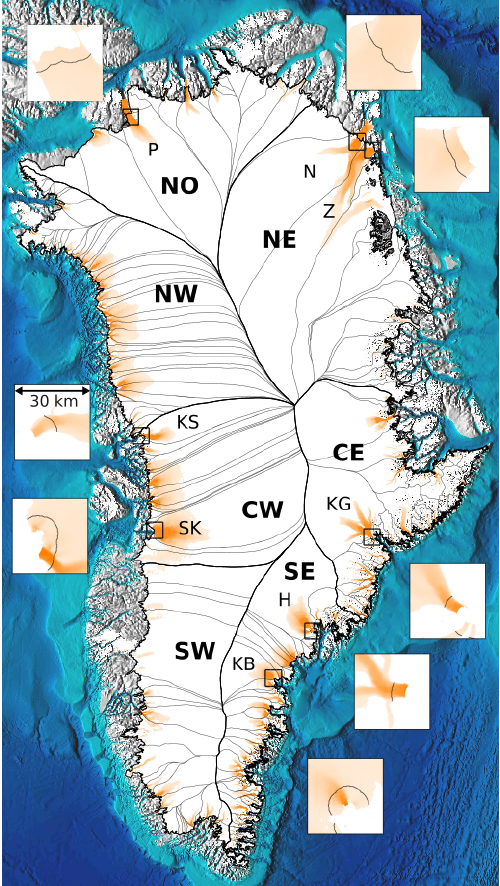
Figure 1. Overview showing fast-flowing ice (orange, greater than 100myr − 1 ) and the gates for the top eight discharging glaciers (Fig. 6). Gates are shown as black lines in inset images. Each in- set is 30 × 30km and all have the same color scaling, but are dif- ferent from the main map. Insets pair with the nearest label and box. On the main map, regions from Mouginot and Rignot (2019) are designated by thicker black lines and large bold labels. Sectors (same source) are delineated with thinner gray lines, and the top discharging glaciers are labeled with smaller font. H: Helheim Glet- sjer; KB: Køge Bugt; KG: Kangerlussuaq Gletsjer; KS: Kangilliup Sermia (Rink Isbræ); N: Nioghalvfjerdsbræ; P: Petermann Glet- sjer; SK: Sermeq Kujalleq (Jakobshavn Isbræ); and Z: Zachariae Isstrøm. Basemap terrain (gray), ocean bathymetry (blues), and ice mask (white) come from